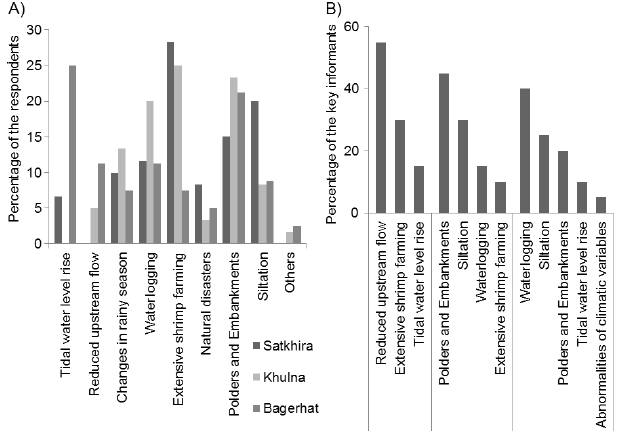
Fig. 3 . Perceived causes of salinity increase by different categories of respondents.